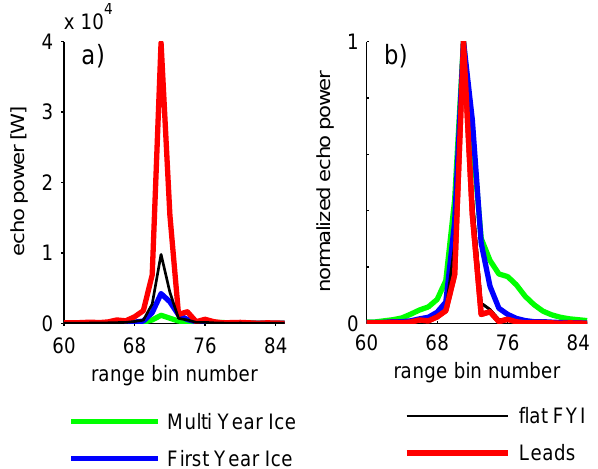
Fig. 4. Averaged waveforms for the three evaluated surface types: Fig. 4: Averaged waveforms for the three evaluated surface types: leads (red), FYI (blue) and MYI (green). Additionally the mean waveform over flat FYI is shown (black). The waveforms have leads (red), FYI (blue) and MYI (green). Additionally the mean been calculated as a mean of all available measurements for these surface type as listed in table waveform over flat FYI is shown (black). The waveforms have been 1. (a) Mean reflected waveform for each surface type. (b) Normalized mean waveform to show the calculated as a mean of all available measurements for these surface difference in the width of the reflected signal. type as listed in Table 1. (a) Mean reflected waveform for each sur- face type. (b) Normalized mean waveform to show the difference in the width of the reflected